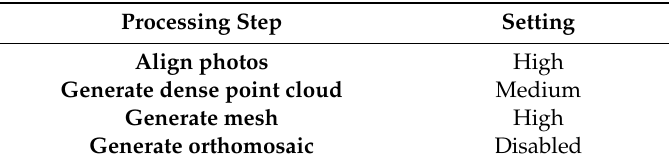
Table 6. Processing settings for Agisoft Photoscan. The same settings were used for all Orthomosaics